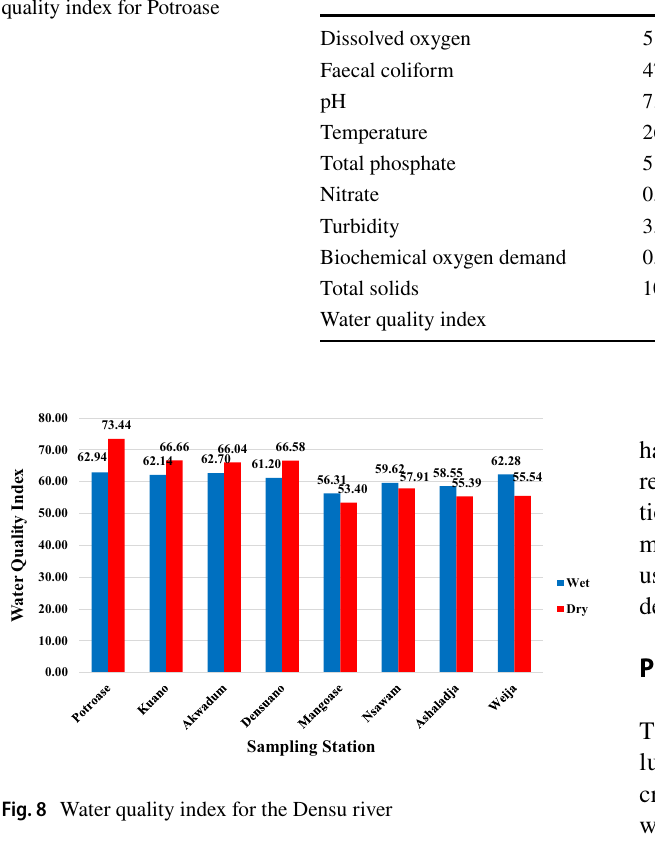
Table 2 Wet season water quality index for Potroase